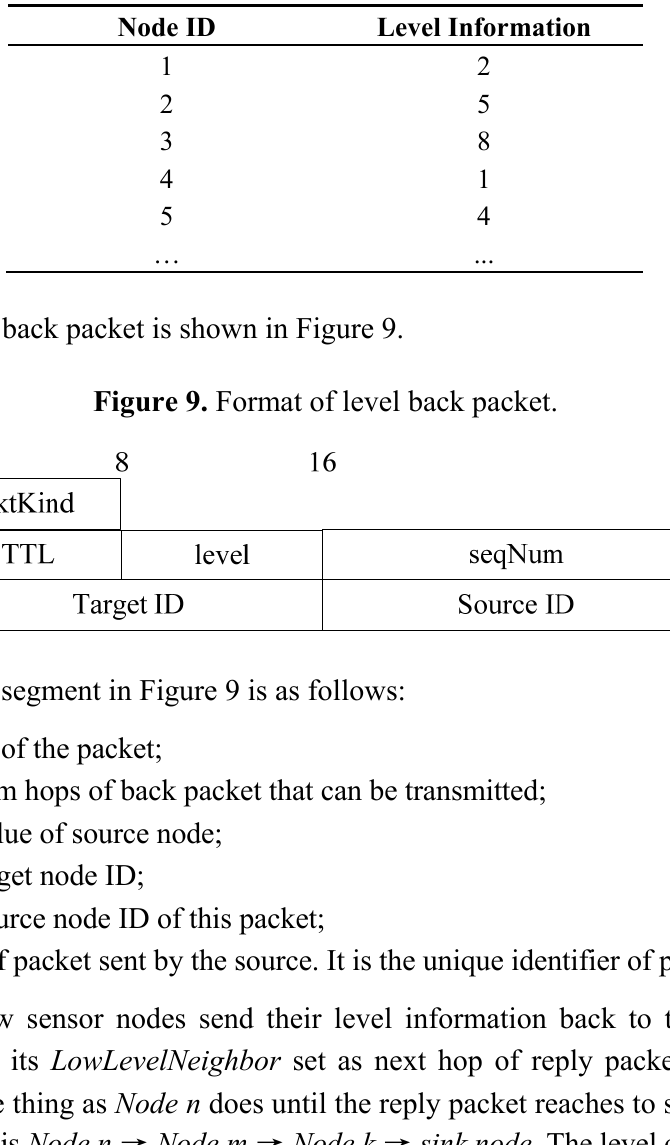
Table 1. Level information table.